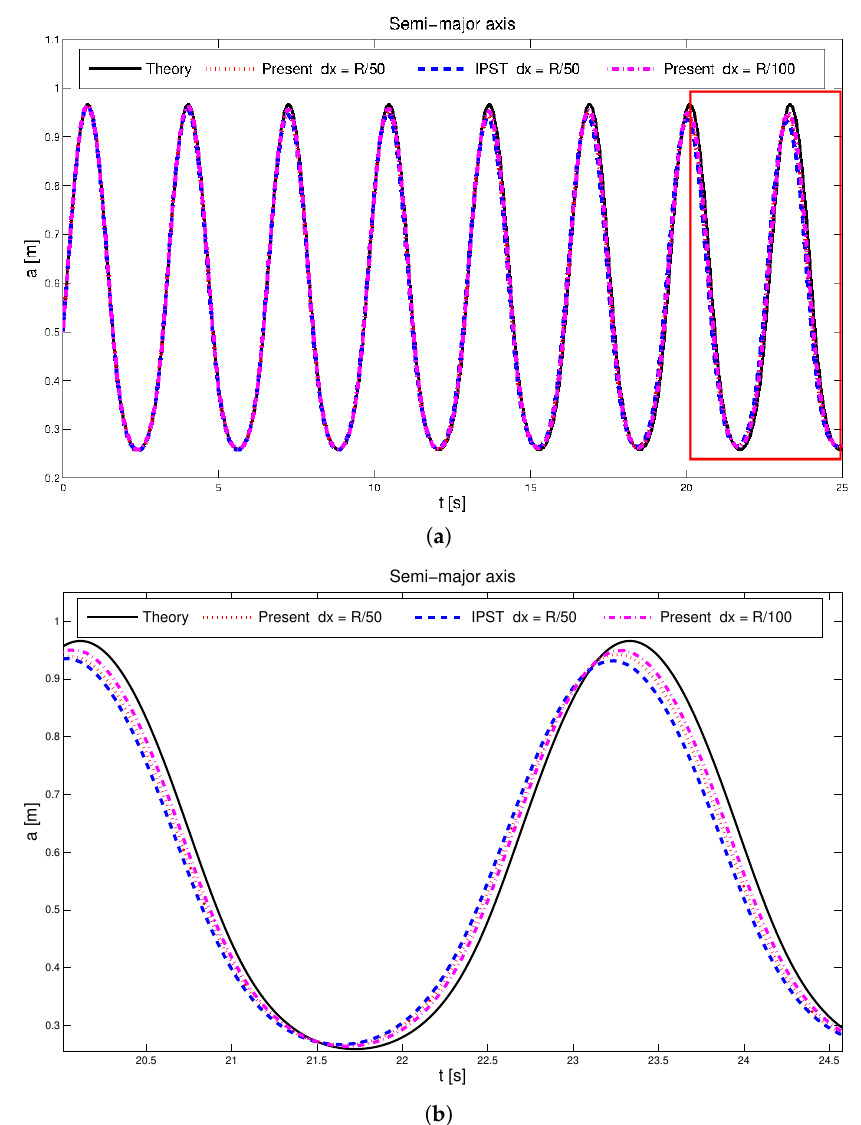
Figure 8. Oscillating droplet under a central conservative force field: horizontal semi major axis evolution in time a ( t ) . The black solid line presents the theoretical results obtained by solving the system (18) [60]. The red dotted line represents the results obtained by the present particle shifting formulation for the fluid droplet of resolution dx = R , whereas for the magenta dash-dot line is for 50 dx = R . The blue dashed line represents the results obtained by the particle shifting technology 100 (IPST) proposed by Wang et al. [37]. The bottom part ( b ) of the figure represents the zoom of selected red rectangle in ( a